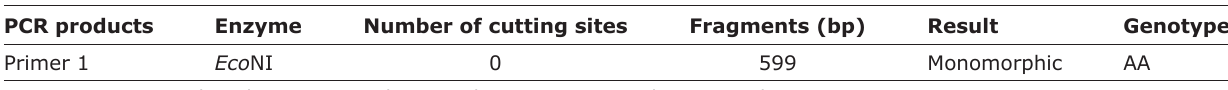
Table-3: Restriction fragment sizes and corresponding genotypes of PPP1R11 gene in Murrah buffaloes using primer restriction enzyme combination. PCR